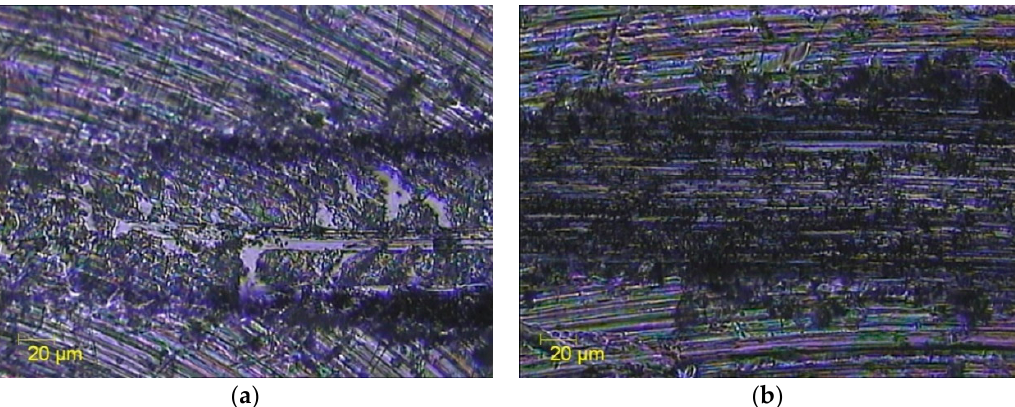
Figure 6 . Scratch micrographs at a normal load of 9000 mN, showing extensive damage (from left to right): ( a ) 100% ZrO 2 coating; ( b ) 33% ZrO 2 coating.